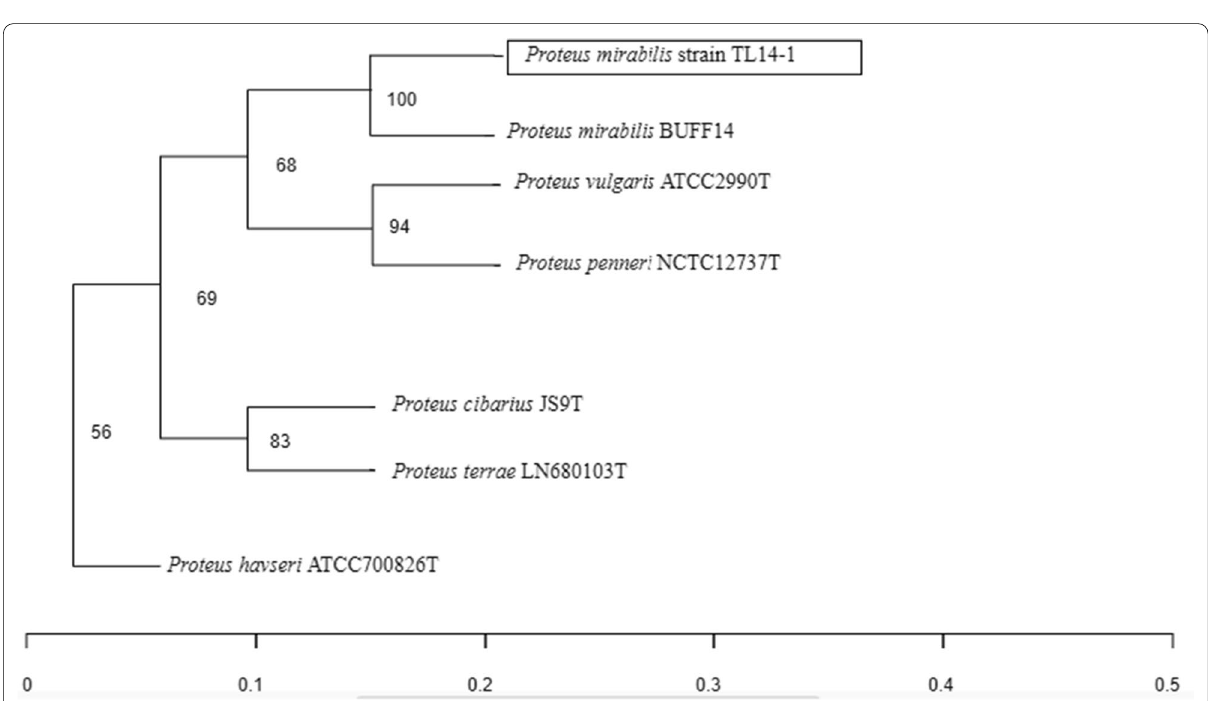
Fig. 17 Phylogenetic tree showing the relationships between the phosphate-solubilizing bacteria (PSB) isolates in this study and their closest phylogenetic relatives based on 16S rRNA gene sequencing. Isolate with rectangle was identified in this